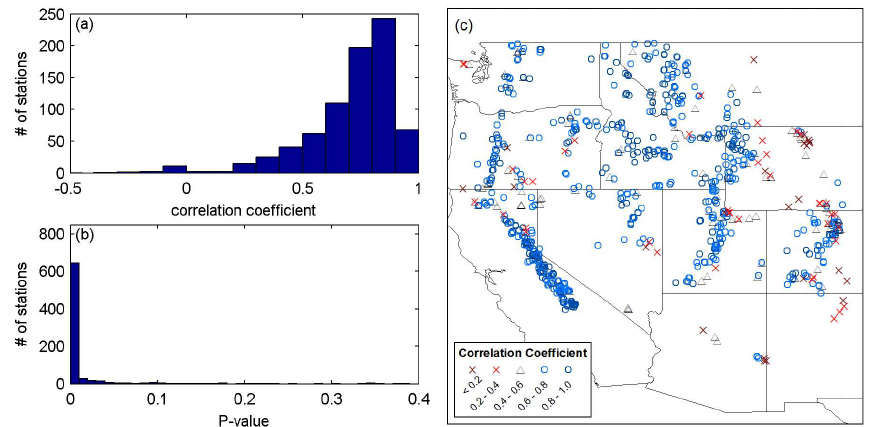
Fig. 13. Correlation coefficients between observed and simulated 1981–2000 1 April snow water equivalent: (a) histogram of correlation coefficients from 784 selected stations, (b) histogram of p value, and (c) spatial pattern of correlation coefficients for all selected stations.